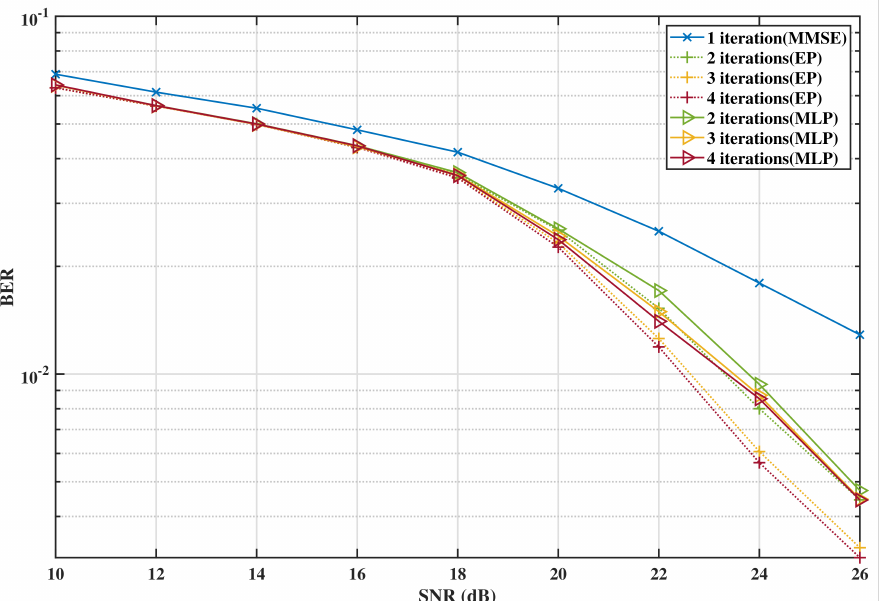
Figure 3. BER performance for the case of the Rayleigh fading MIMO channel scenarios with n = 8, m = 8, and 256-QAM constellation.